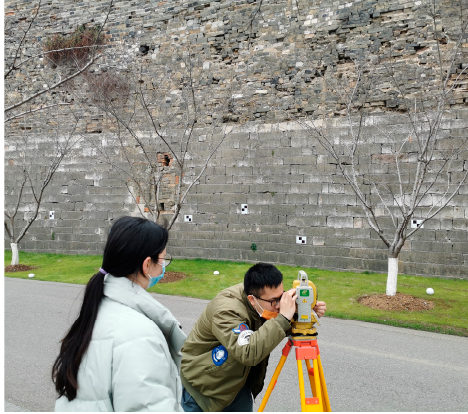
Figure 9. Surveying the cracks with the prism-free total station .